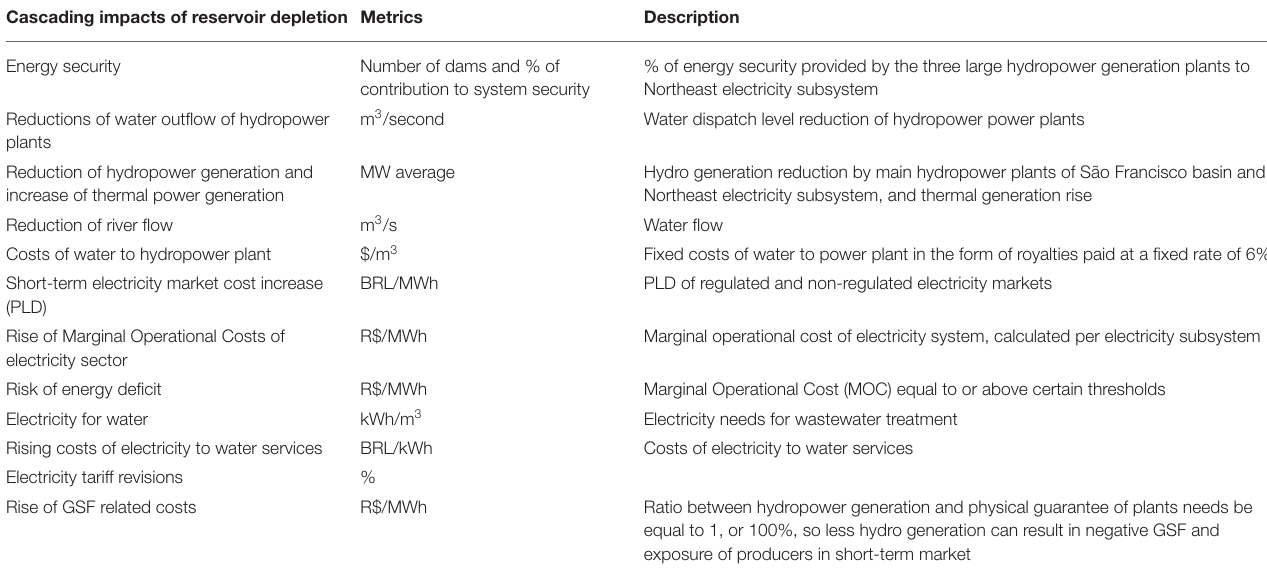
TABLE 1 | Metrics on cascading impacts of reservoir